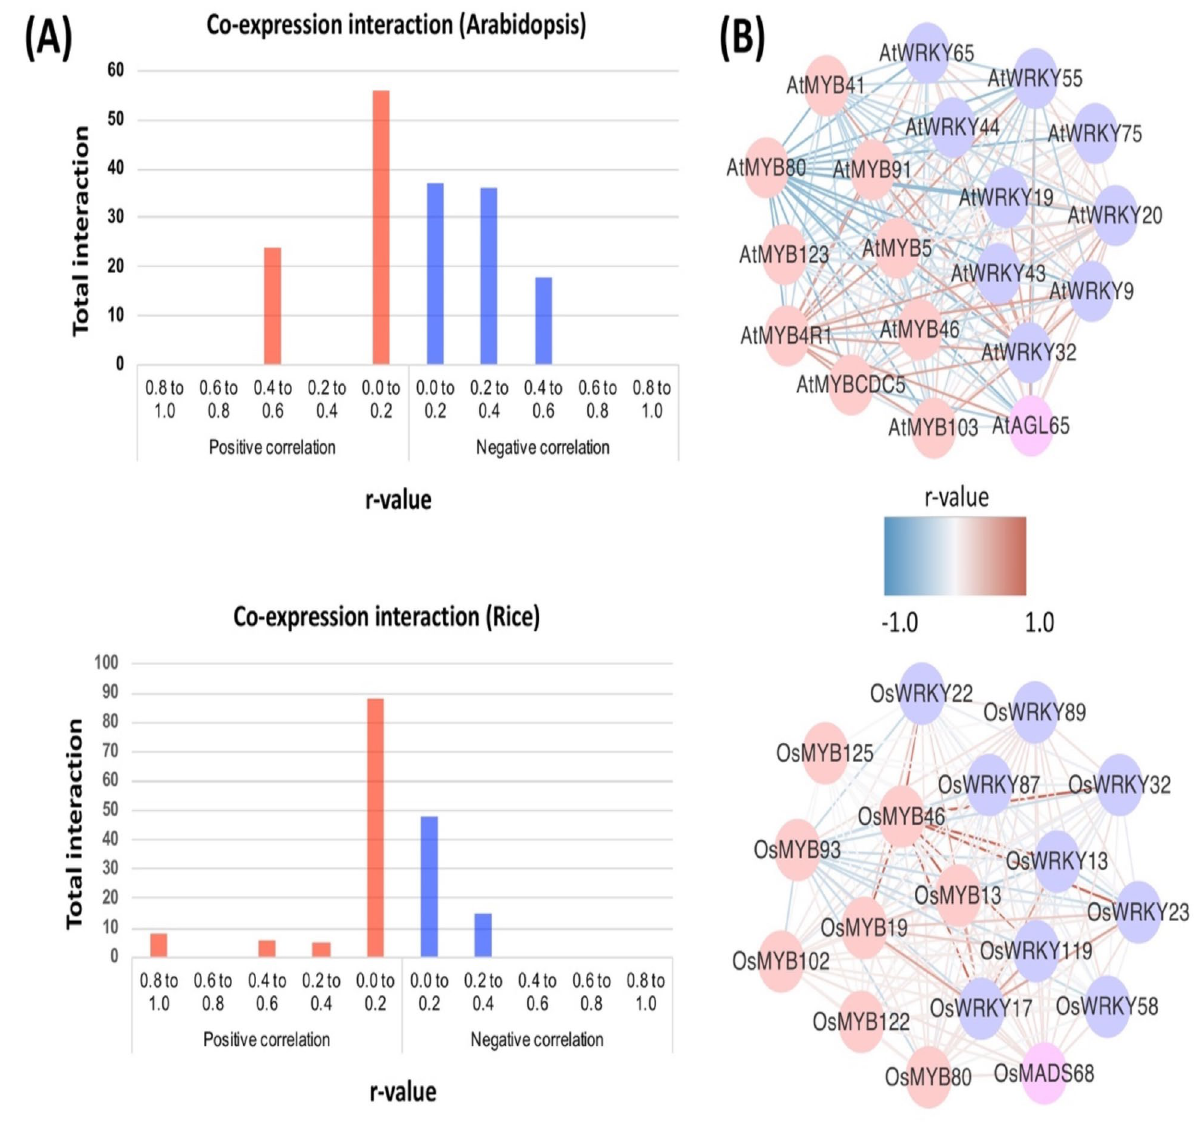
Figure 8. Gene co-expression network of Arabidopsis and rice WRKY, MADS-box and MYB orthologous genes. ( A ) Frequencies of co-expression interactions identified by PLANEX. Increasing r-values show stronger positive correlation and vice versa. ( B ) Co-expression network comprised of nodes, represent genes, different node colour s indicate unique transcription factor family (red node = MYB, blue node = WRKY and purple node = MADS-box) and edges indicate positive (red lines) and negative (blue lines)